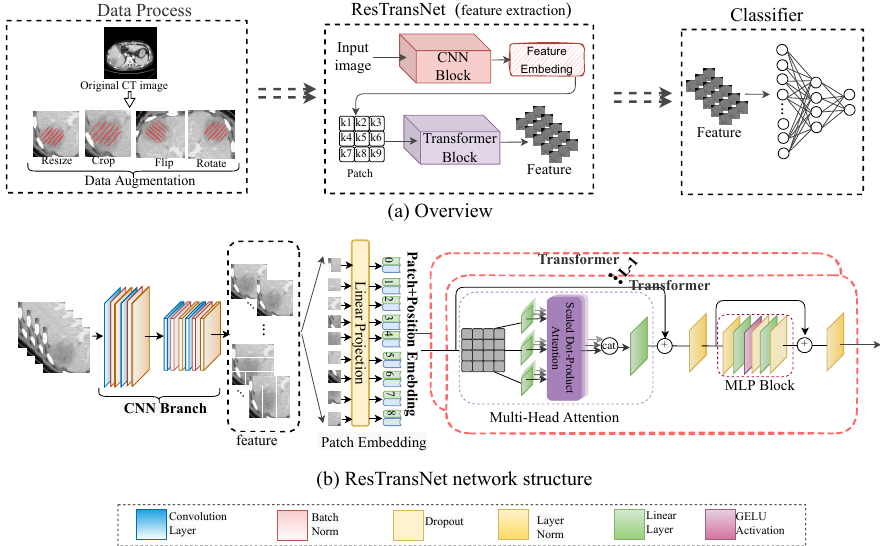
Figure 2. ( a ) Workflow overview including data processing and feature extraction network: Re- sTransNet and a nonlinear classifier. In the data processing phase, the image was the patient’s preoperative CT, and the label was the status of PD-1 expression (0: PD-1-negative; 1: PD-1-positive), with a cut-off of 5% in our study. We expanded the sample by resizing, cropping, flipping, and ro- tating the image to improve the robustness and reduce overfitting. ( b ) The ResTransNet network framework consisted of a CNN branch and a transformer branch. Patch Embedding displays the process of feature transformation into the patch. The classification network contained 3 residual blocks and 12 transformer blocks. The ResTransNet was applied to extract